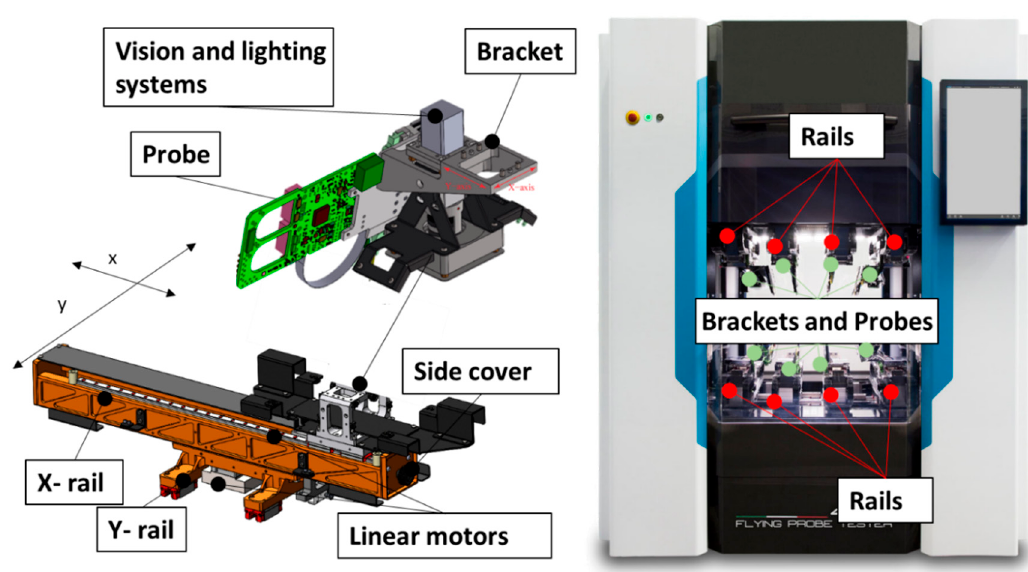
Figure 2. Case study. The systems that are subjected to redesigning are the X and Y rails and the